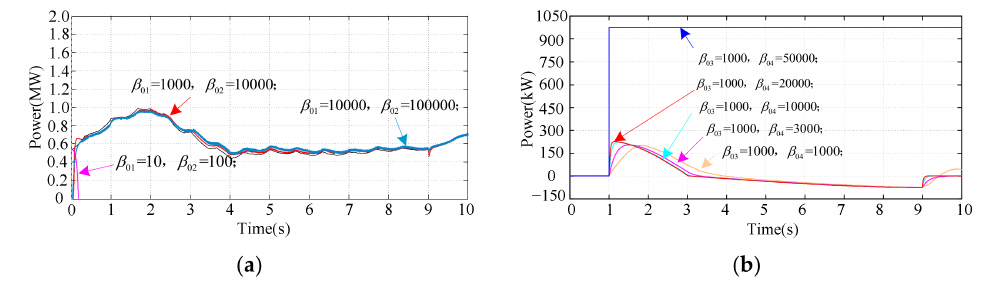
Figure 7. Comparison of DFIG mechanical input power estimation with ESO under different parameters: ( a ) comparison of estimation with ESO-A under different β 01 , β 02 ; ( b ) comparison of estimation with ESO-B under different β 01 , β 02 .